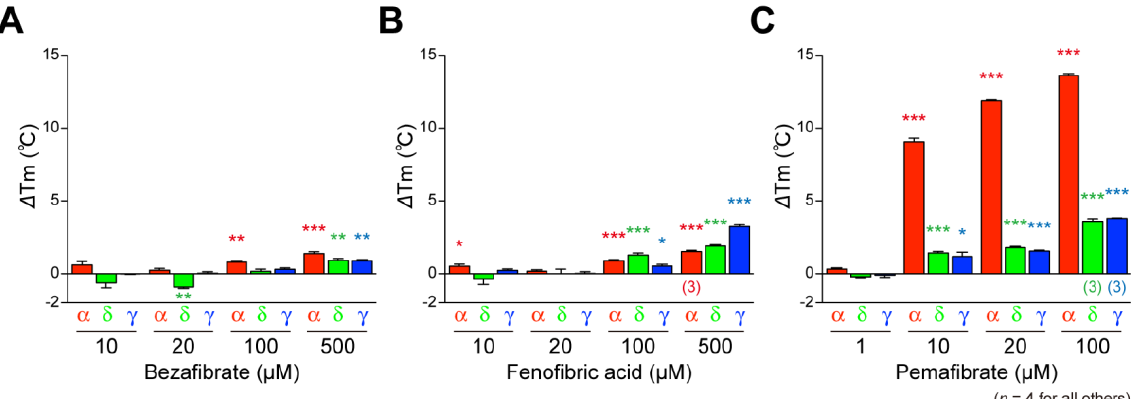
Figure 3. Circular dichroism-based PPAR α / δ / γ -LBD thermostability assay. Bezafibrate — ( A ), fenofibric acid — ( B ), and pemafibrate-dependent ( C ) increases in T m values ( ∆ T m ) at 222 nm were measured as the reflection of the thermostability of α -helical structures in PPAR α / δ / γ -LBD. Data are means ± SE of four independent experiments ( n = 3 for 500 µM fenofibric acid on PPAR α -LBD and 100 µM pemafibrate on PPAR δ / γ -LBD). Differences versus basal (0.1% DMSO) levels are significant in * p < 0.05, ** p < 0.01, and *** p < 0.001 in Student ’ s t -test.